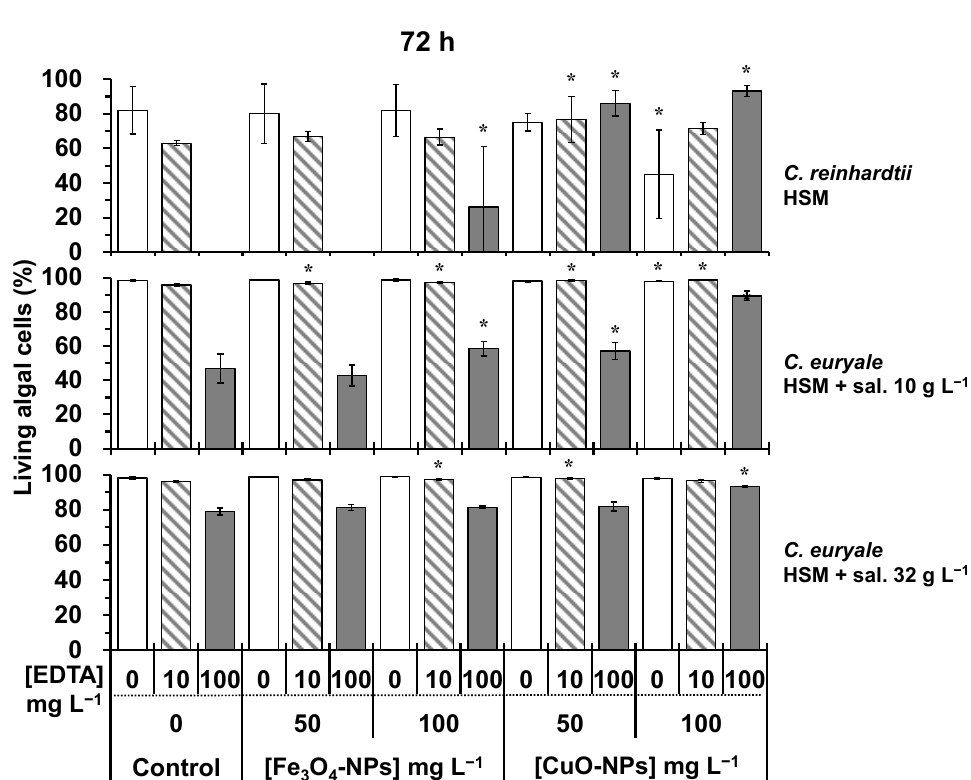
Figure 8. Living algal cells (in %) at 72 h for the control and treated cells to 50 and 100 mg L − 1 Fe 3 O 4 - NPs or CuO-NPs: C. reinhardtii in HSM; C. euryale in HSM under two salinity conditions, 10 g L − 1 and 32 g L − 1 . Under these conditions, algal cells were exposed to EDTA concentrations: 0 (white), 10 mg L − 1 (dash), and 100 mg L − 1 (gray). (*) Significant differences between the controls and treatments ( p < 0.05) were determined by one-way ANOVA and Tukey post-hoc test.